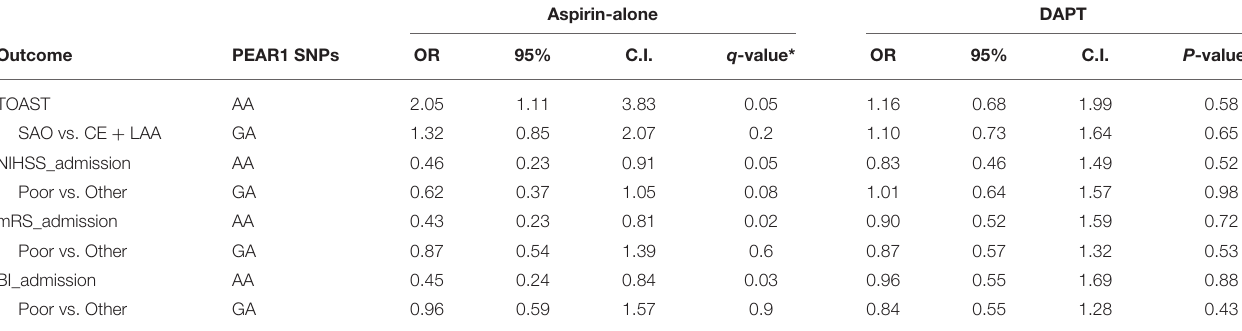
TABLE 2 | Association between PEAR1 SNPs and TOAST subtype and admission outcomes in univariate logistic regression models. Aspirin-alone DAPT Outcome PEAR1 SNPs